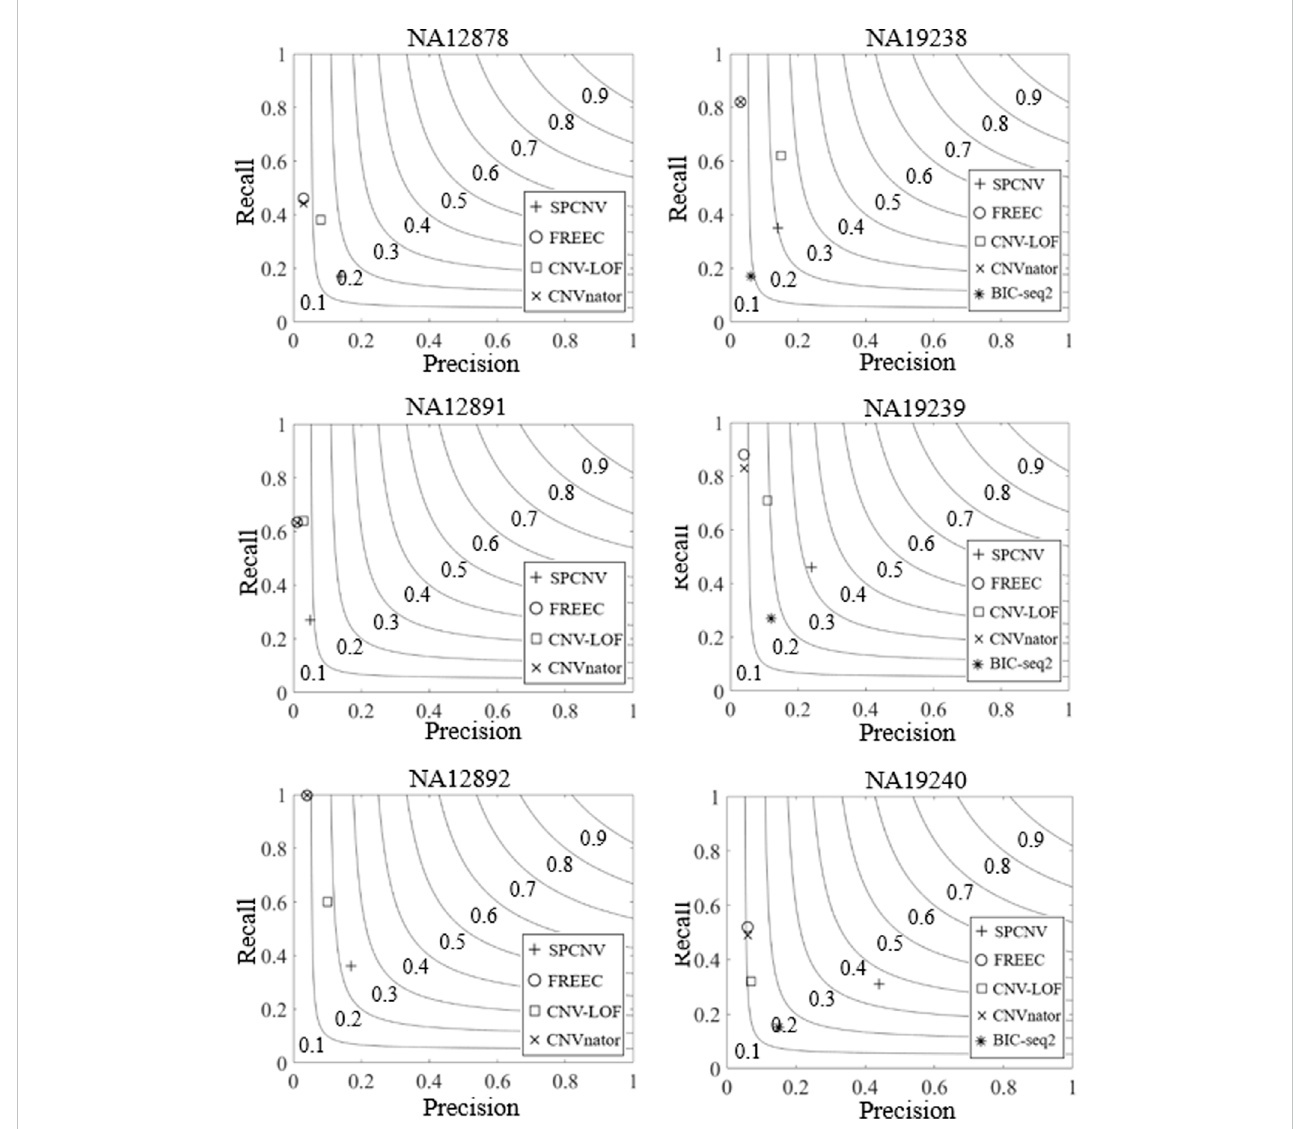
FIGURE 6 The performance of the fi ve methods is comparedin terms of recall, precision, and F1-score across six real data samples. Black curves indicate F1-score levels that are harmonic means of recall and precision ranging from 0.1 to 0.9.